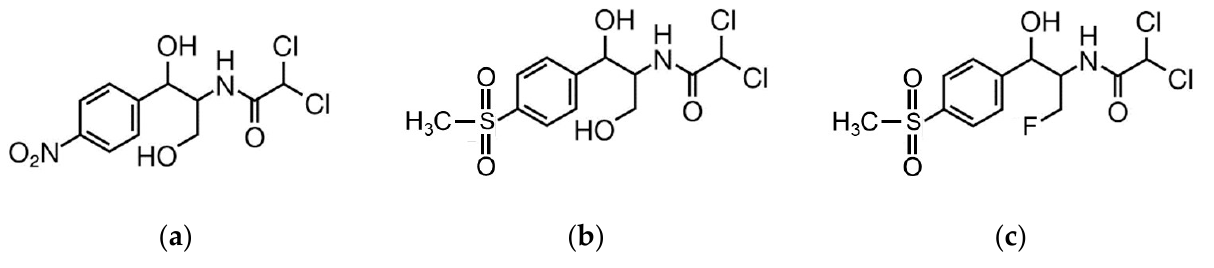
Figure 1. Chemical structure of ( a ) chloramphenicol (CAP); ( b ) thiamphenicol (TAP); ( c ) florfenicol (FF).